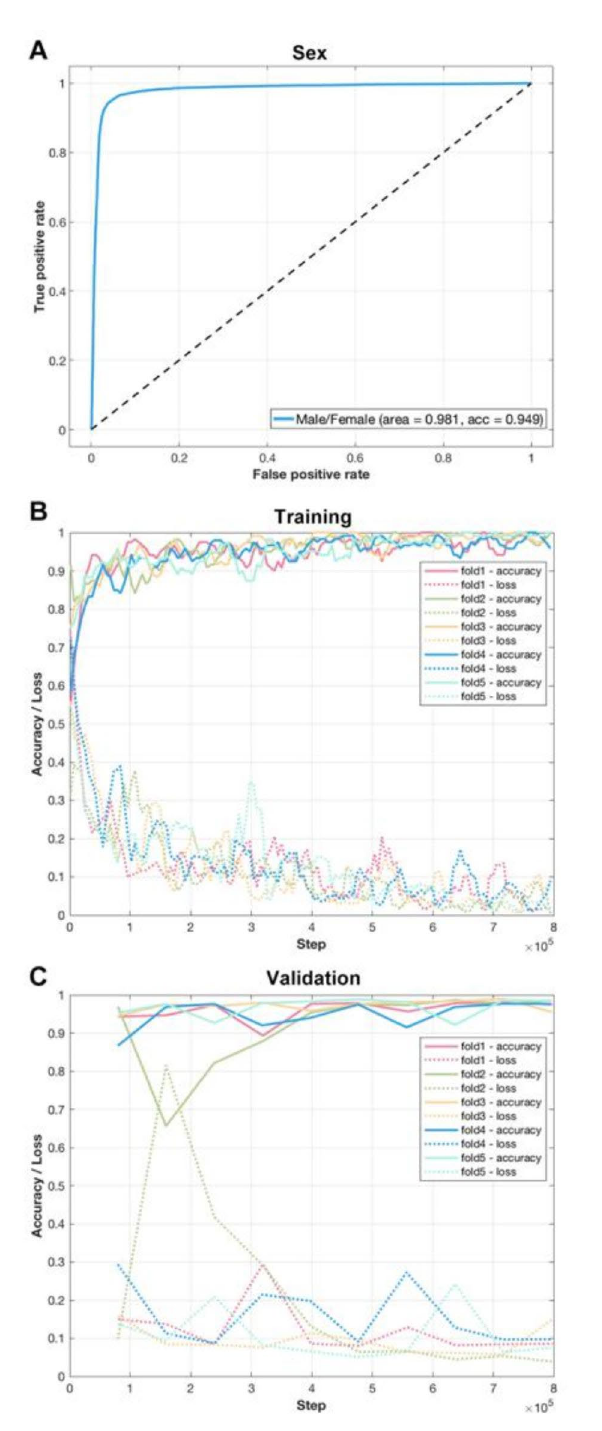
Fig. 2 Performance of the sex classifier. ( A ) The receiver operating characteristic curve of the sex classifier. ( B ) The tensorboard monitor graph of the sex classifier in the training sample. The curve was smoothed for better visualiza- tion. ( C ) The tensorboard monitor graph of the sex classifier in the validation respectively. The AD classifier achieved 93.6% accuracy in MIRIAD with 0.994 AUC (Fig.3E). Sensitivity and specificity were 0.897 and 1.000, respectively. The AD classifier